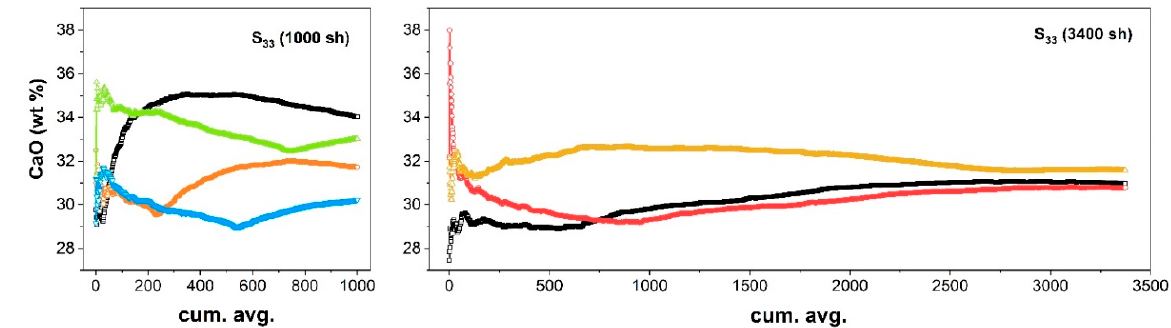
Figure 5. CaO concentration as predicted using the cumulative averaged spectrum in random scans of 1000 sh (left) or 3400 sh (right) in different areas of the nonhomogeneous rock slice (S 33 ).